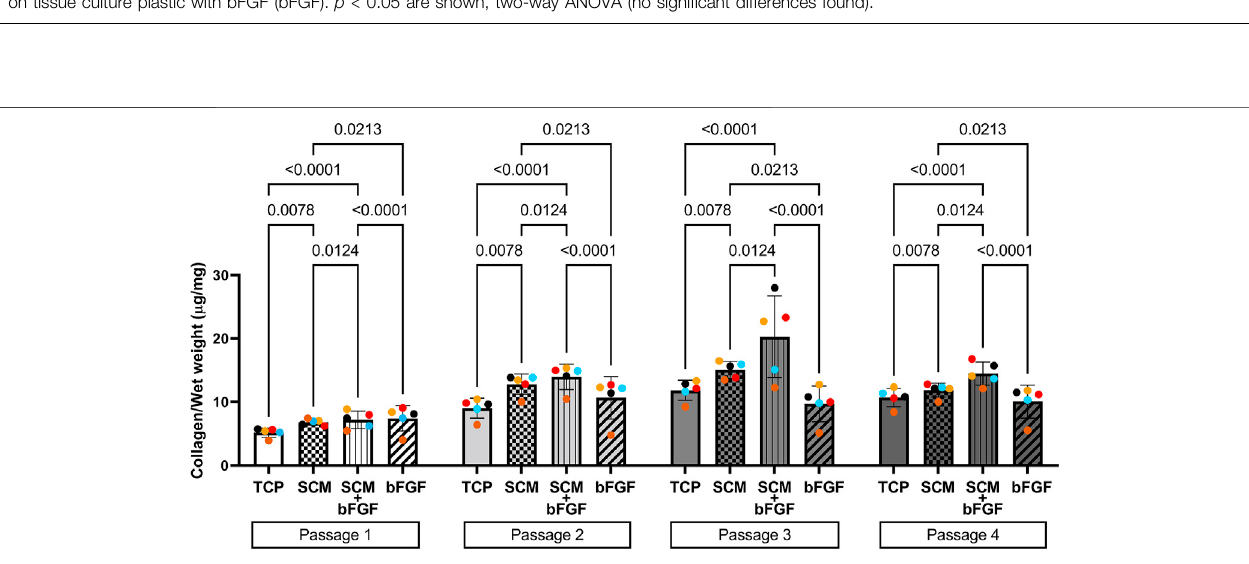
FIGURE4| Collagencontentofhumancartilageaggregates. Cartilageaggregatesfrom fi vedonors(average aggregatecollagencontentpermgwetweight, ≥ two aggregates per donor, each color represents a donor) for four passages on tissue culture plastic (TCP), synoviocyte-derived extracellular matrix (SCM), on synoviocyte matrix with bFGF (SCM + bFGF), or on tissue culture plastic with bFGF (bFGF). p < 0.05 are shown, two-way ANOVA.